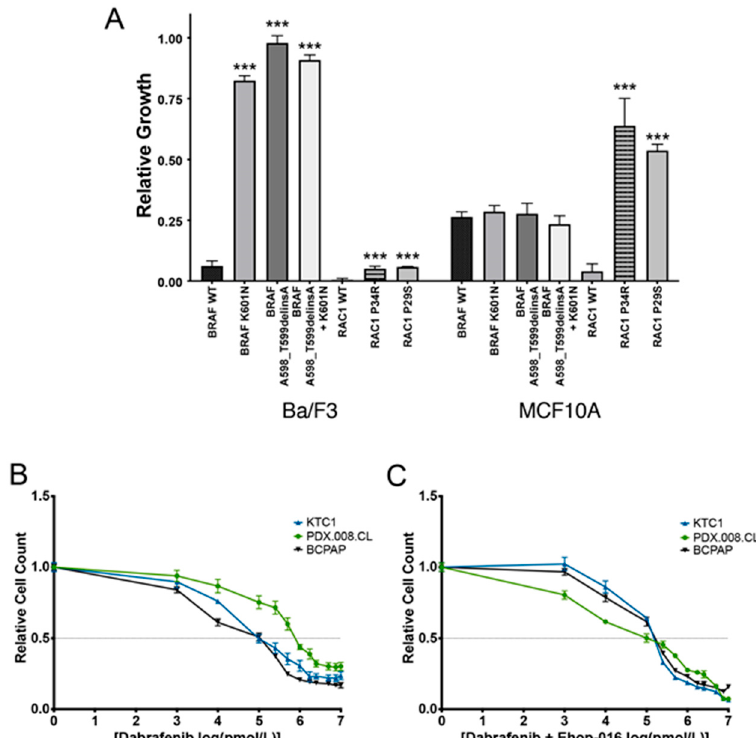
Figure 2. Effects of BRAF and RAC1 mutations on the proliferation of different cell types. ( A ) The effects of the BRAF (A598_T599delinsA) and (K601N) mutations separately or combined, as well as the effects of the RAC1(P34R) and RAC1(P29S) mutations on the growth of murine Ba/F3 pro-B cells and human MCF10A normal breast epithelial cells were tested in culture. Cells were transiently transfected with lentiviral expression vectors and cultured without the addition of growth factors (interleukin 3 for Ba/F3 and EGF for MCF10A cells). Data indicated that the BRAF mutations significantly affected the growth of lymphoid cells while the RAC1 mutations significantly affected the proliferation of the breast epithelial cells. n = 3, *** = p < 0.005. ( B ) The effect of dabrafenib on the proliferation of KTC1, BCPAP, and PDX.008.CL cells was evaluated in a dose–response assay. The half maximal inhibitory concentration (IC50) value for dabrafenib was 0.1 µM for both KTC1 and BCPAP cells, while the IC50 value was 1 µM for the PDX.008.CL cell line, indicating a 10-fold resistance to dabrafenib of this cell line in comparison to the other lines. ( C ) The effect of the RAC1 activity inhibitor EHop-016 in combination with dabrafenib on KTC1, BCPAP and PDX.008.CL cells was evaluated. EHop-016 restored the dabrafenib sensitivity of PDX.008.CL cells back to the levels of KTC1 and BCPAP cells (IC50 = 0.1 µ M), indicating that the RAC1 mutation had a major effect on dabrafenib